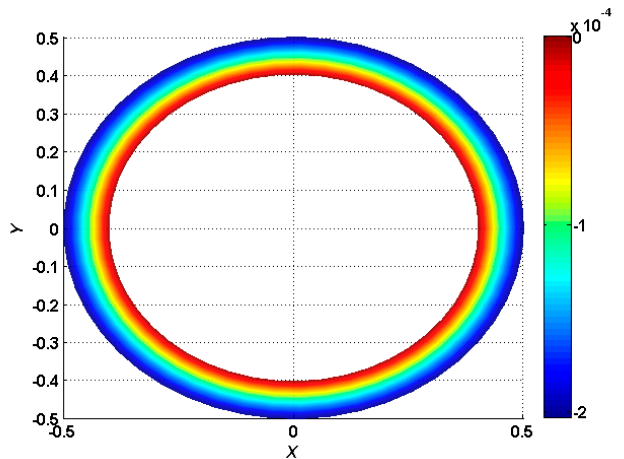
with torus 0.5 h R = and internal w wE h q = Al ,